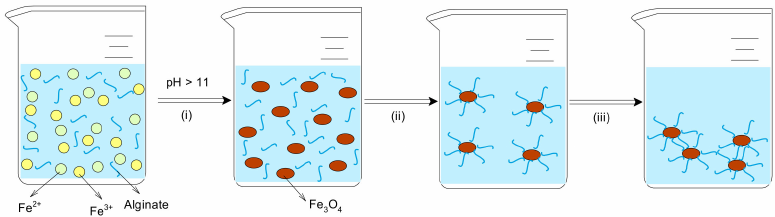
Figure 2. Schematic illustration of the formation of Alg-Fe 3 O 4 -MPs.